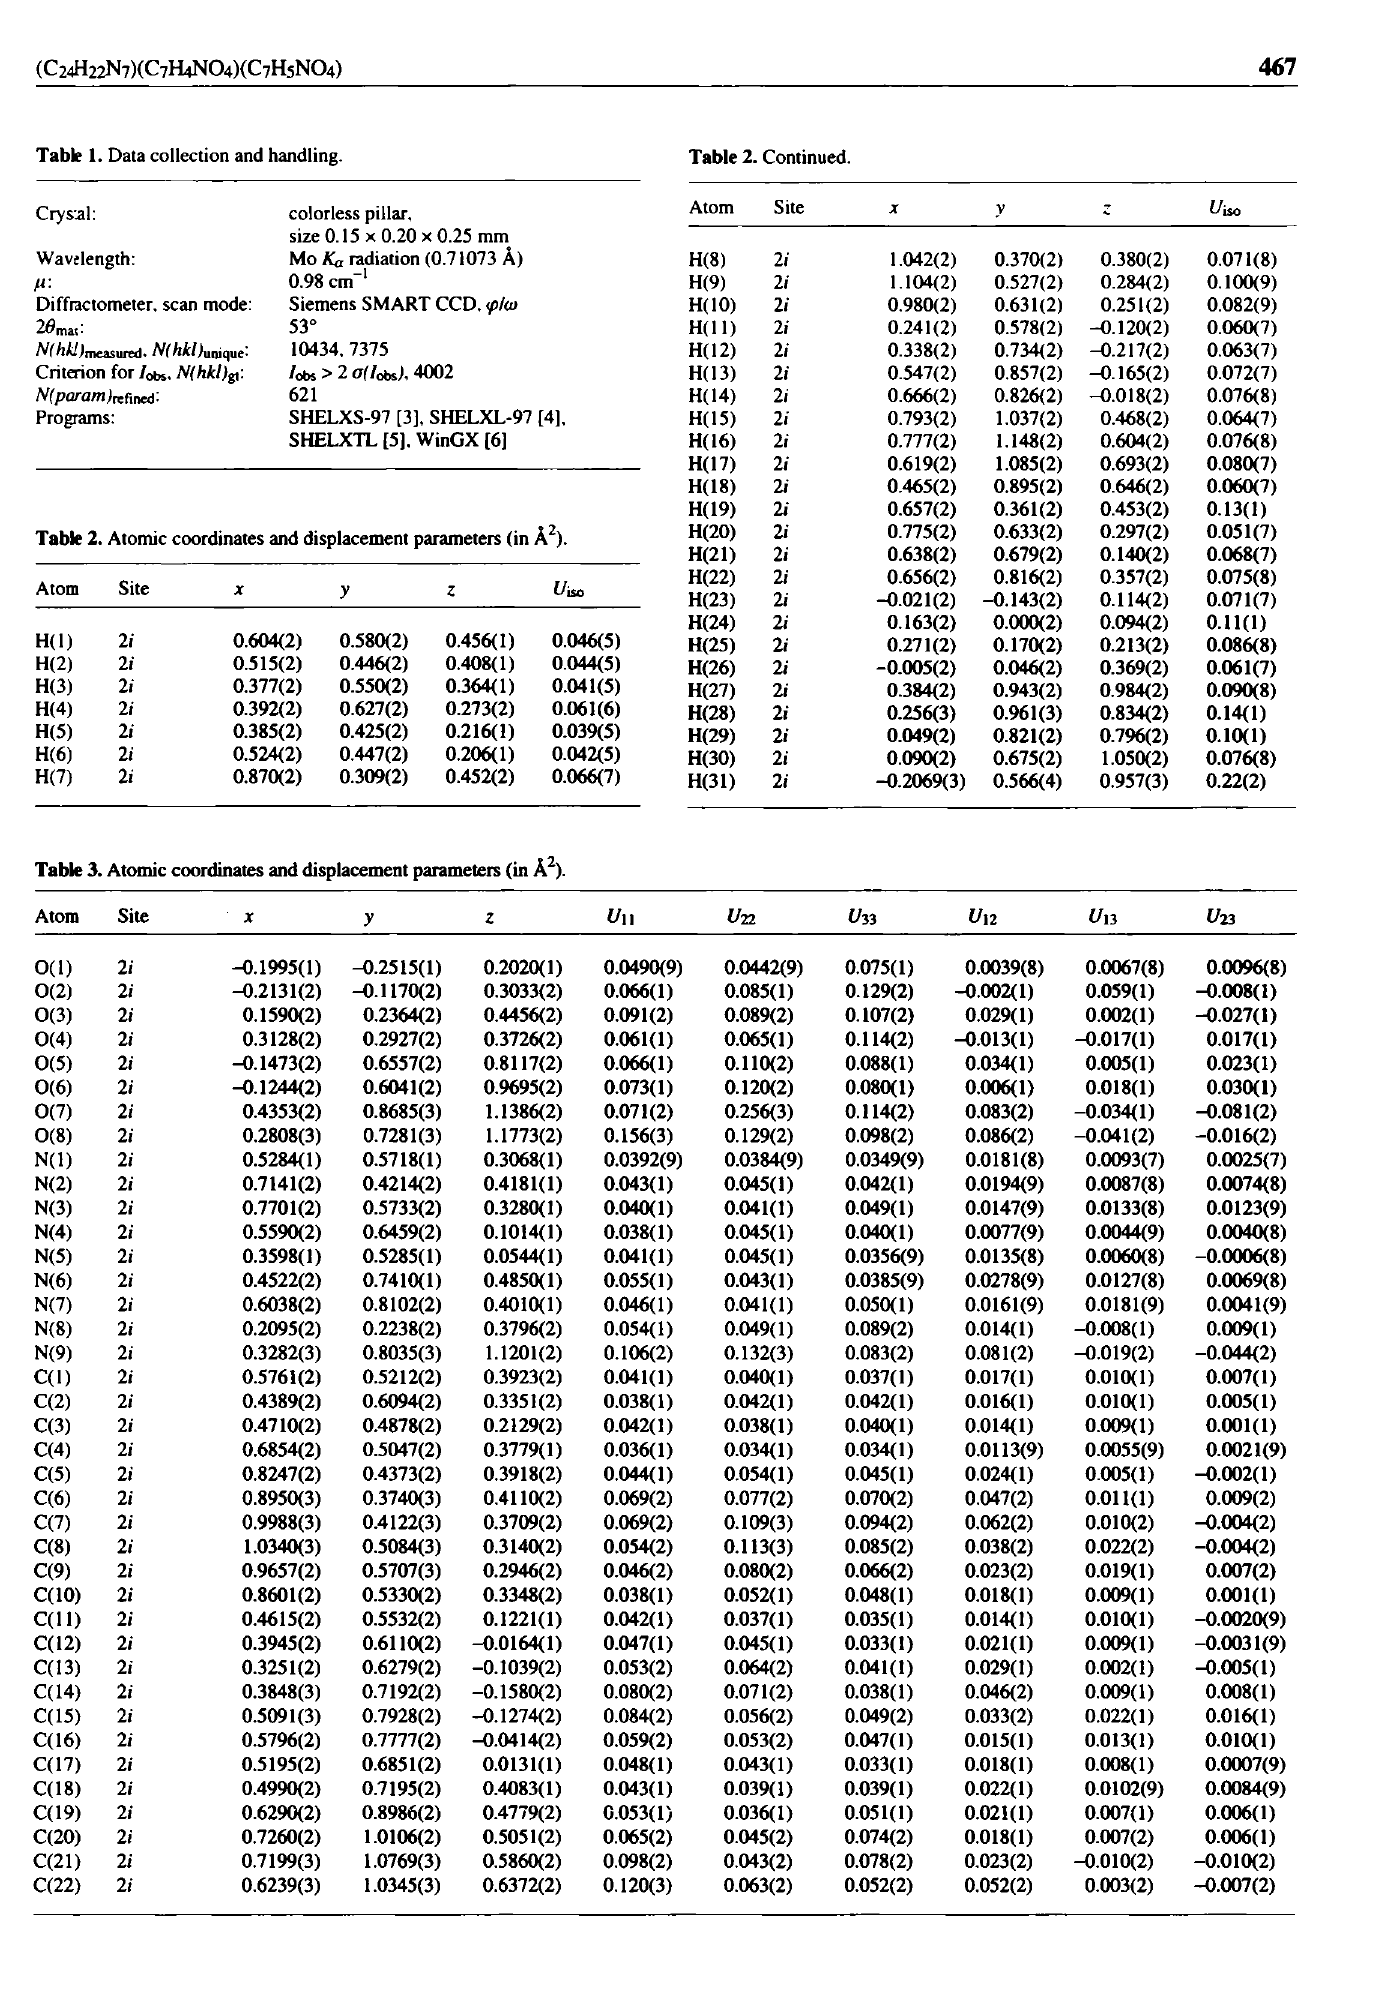
Table 3. Atomic coordinates and displacement parameters (in A 2